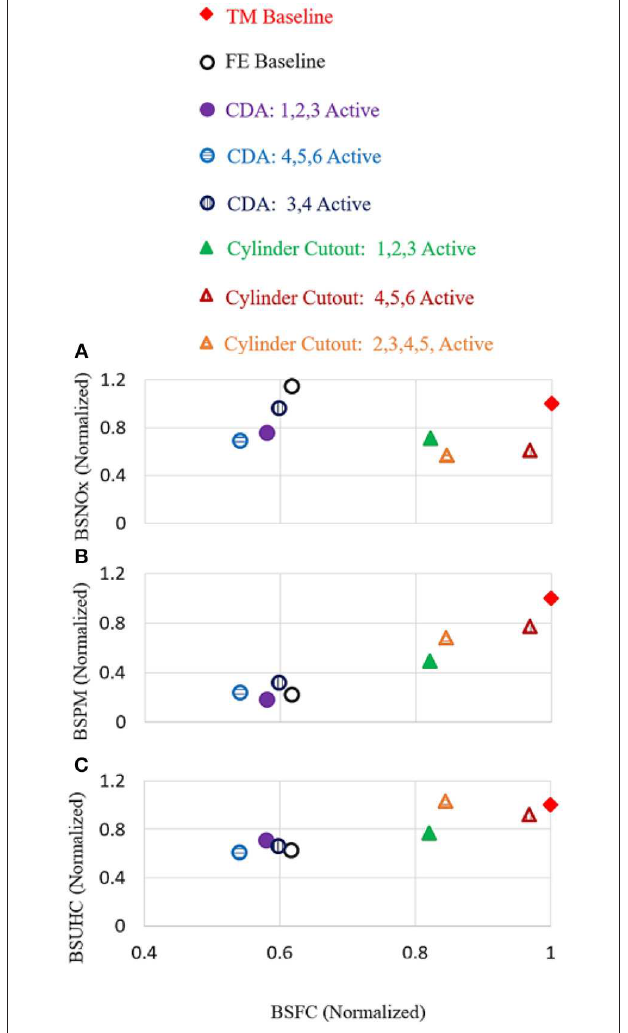
FIGURE 6 | (A) Normalized BSNOx relative to TM Baseline . (B) Normalized BSPM relative to TM Baseline . (C) Normalized BSUHC relative to TM Baseline